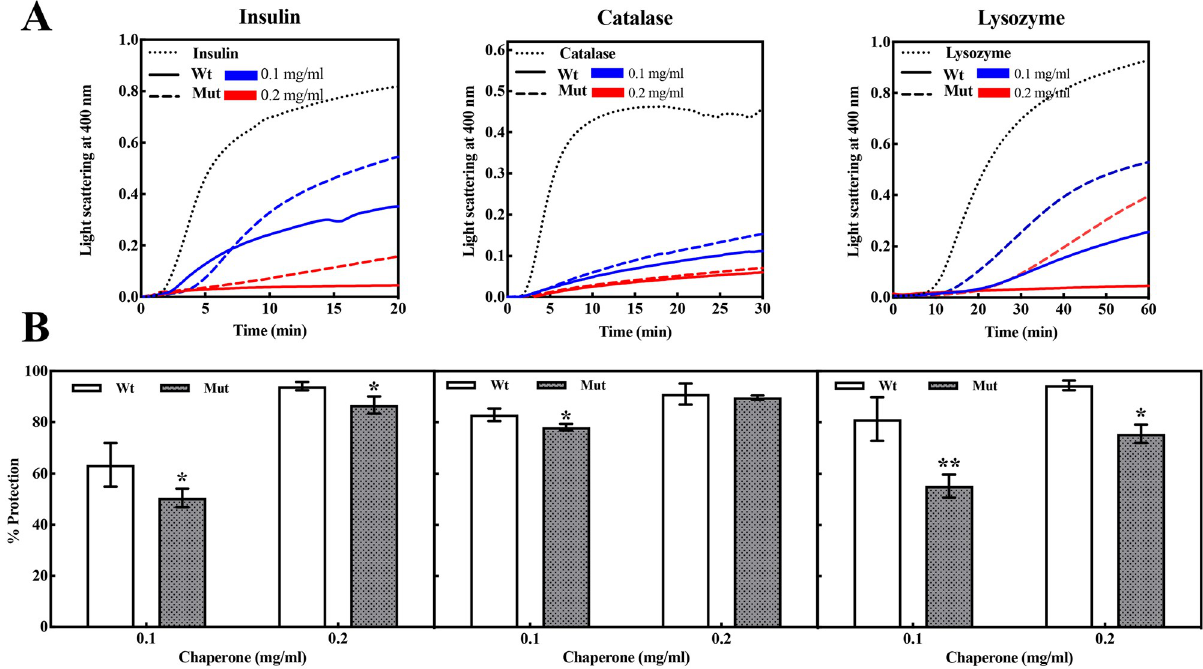
Fig 5. Chaperone-like activity assessment of wild-type and D109A α B-crystallins using three different target proteins. A ) The aggregation of insulin (0.3 mg.mL -1 ) and lysozyme (0.2 mg.mL -1 ) was induced in the presence of 20 mM of DTT, at 40 ˚C, while the aggregation of catalase (0.3 mg. mL -1 ) was initiated at 60 ˚C. The light scattering spectra were recorded at 400 nm in the presence and absence of 0.1 mg.mL -1 and 0.2 mg.mL -1 of wild- type and D109A α B-crystallins, respectively. B ) The bars represent the SD of three independent repeats and the significant difference in the percentage of protection which is marked with star ( � p < 0.05, �� p < 0.01, ��� p <